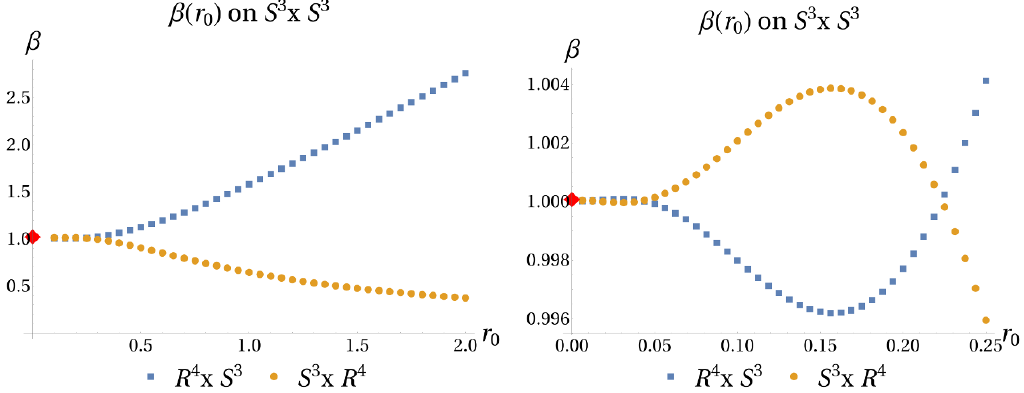
Figure 8 . The ratio of radii (cid:12) as a function of the closing radius r 0 for both topologies with conformal boundary S 3 (cid:2) S 3 . The red diamond is the analytical calculation for the singular ratio (cid:12) s .